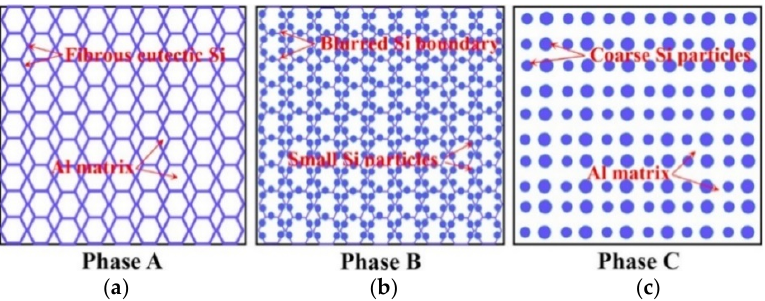
Figure 43. Schematic illustration showing the microstructure evolution of SLM AlSi10Mg samples in the ( a ) as-prepared state, after ( b ) solutionizing treatment and ( c ) after artificial ageing heat treatment. Si-rich areas are marked with blue color, whereas white matrix represents the Al-rich areas [160]. Adapted with permission from Elsevier Science Ltd. under the license number 4803740322935 (Figure 5 [160]),